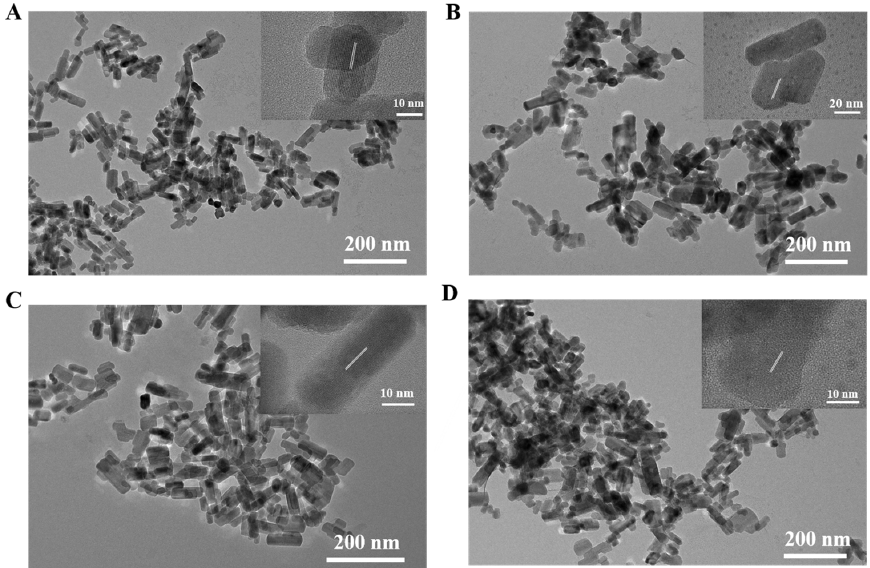
Figure 1. Transmission electron microscope ( TEM) and high resolution (HR)TEM (insets) images of Zn 2 GeO 4 :Mn nanorods synthesized in 2 h ( A ), 4 h ( B ), 6 h ( C ), 8 h ( D ).